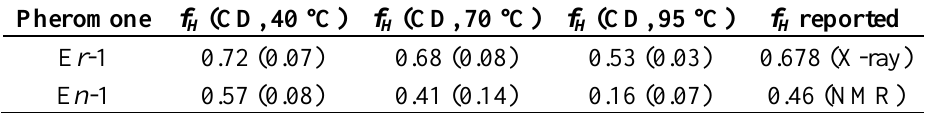
Table 2. Values of fractional helicity f at different temperatures for the E r -1 and E n -1 H proteins, obtained by DICHROWEB/CONTINLL-4 analysis. The values in parenthesis are the corresponding normalized root mean square deviations. The last column reports the values of fractional helicity f of E r -1 and E n -1 as established by X-ray [27] and NMR [23], H